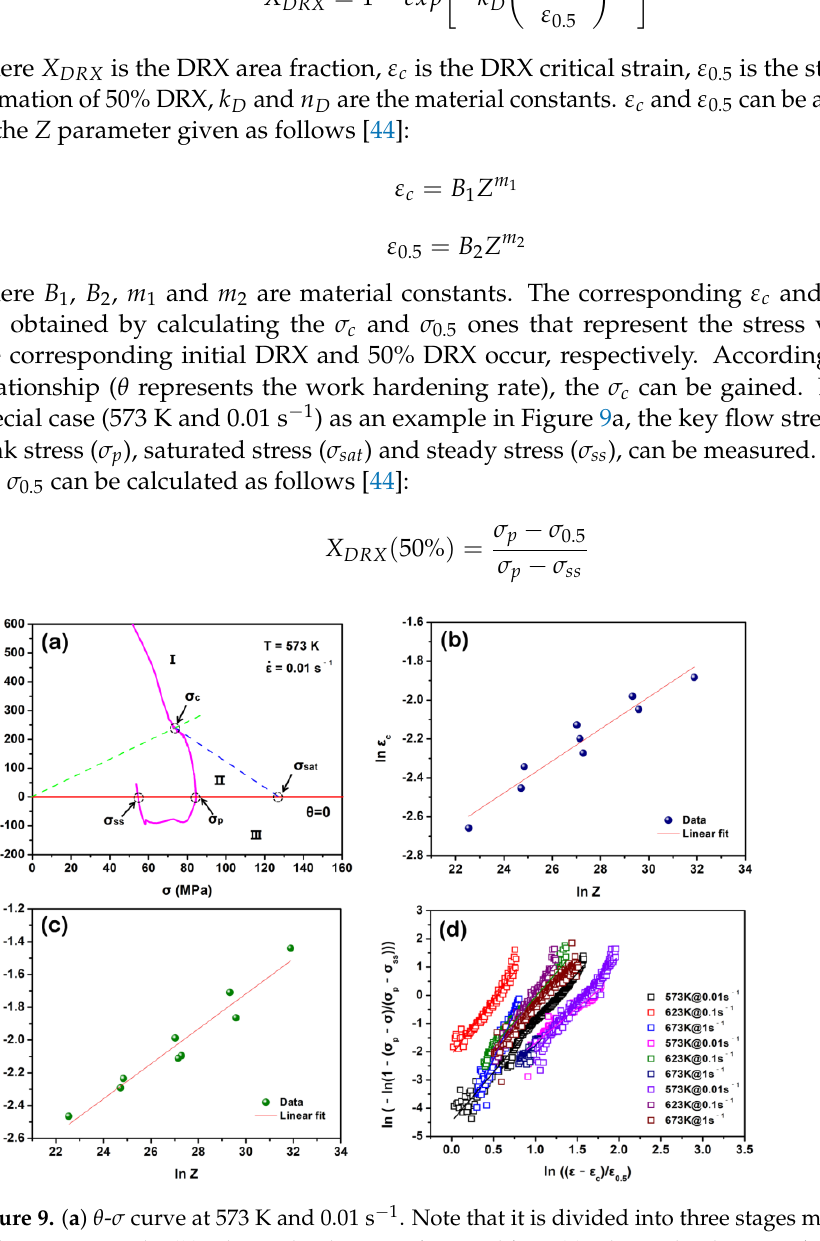
Table 2. σ c , σ 0.5 , ε c and ε 0.5 values at different deformation conditions. Deformation Temperature (K) Strain Rate (s −1 ) 573 623 673 σ c (MPa)